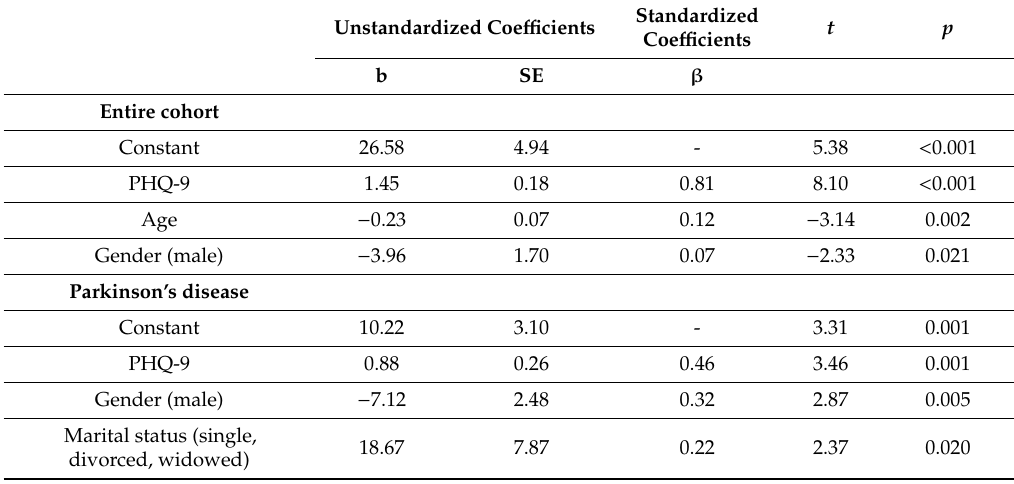
Table 4. Linear regression analysis: Predictors of the di ff erence between current and desired quality of